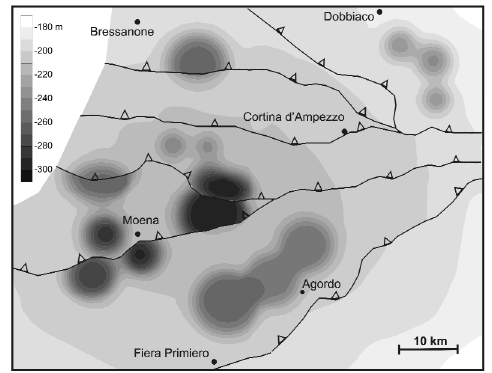
Fig. 10. Map of the calculated subsidence occurred during Middle Triassic and reduced to its present-day distribution after considering the Tertiary contrac-